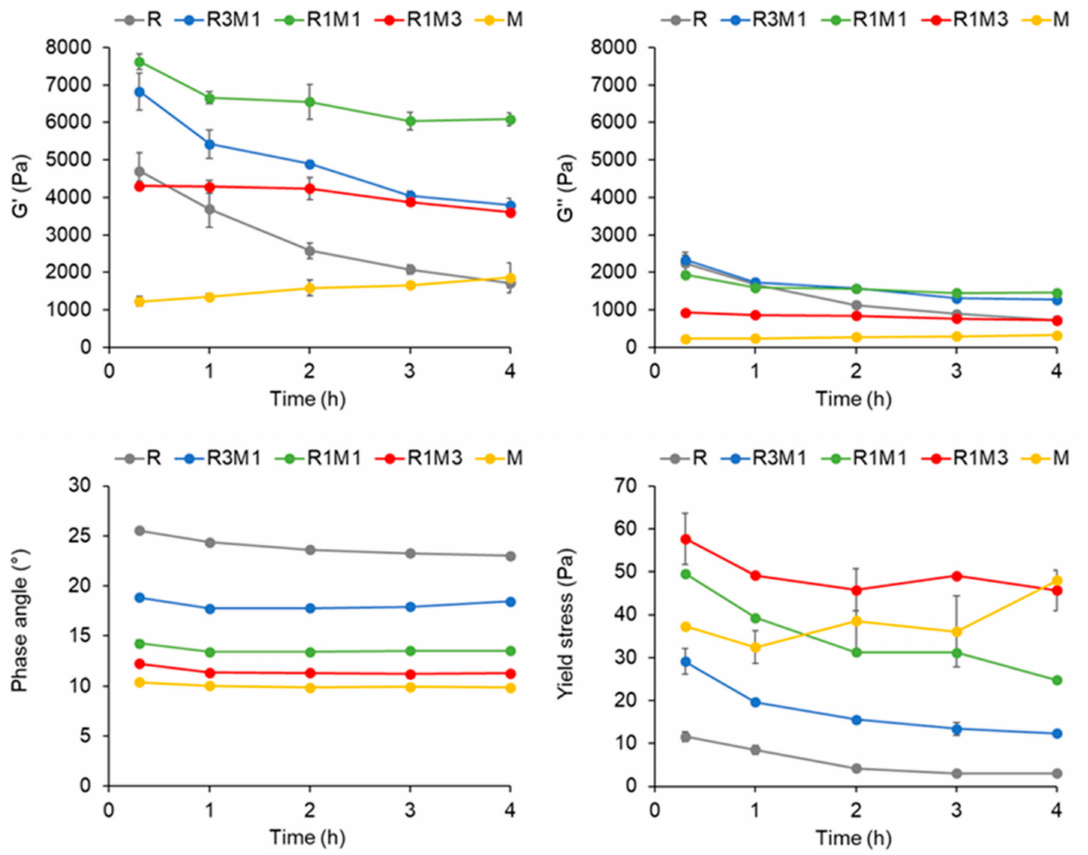
Figure 2. Changes in viscoelastic properties, i.e., G’, G” and phase angle in linear viscoelastic region and yield stress, of printing pastes over a 4 h period after preparing the pastes. R, the rye flour-based paste; M, milk powder-based paste; R1M3, paste composed of 25% rye flour and 75% milk powder; R1M1, paste composed of 50% rye flour and 50% milk powder; R3M1, paste composed of 75% rye flour and 25% milk